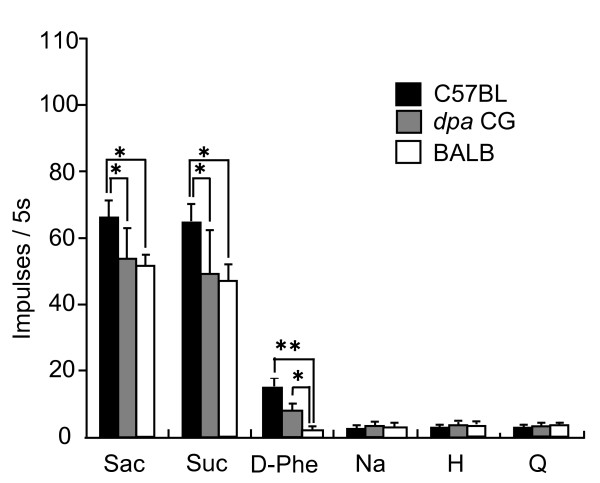
Mean numbers of impulses/5 sec of all sweet-sensitive fibers including GS and GI types in response to 6 taste stimuli in C57BL, dpa CG and BALB mice. Two-way repeated ANOVA tests indicated that the mean number of impulses to Sac, Suc and D-Phe significantly differed among the 3 strains [F (2, 77) = 3.70, P < 0.05 for Sac; F (2, 77) = 4.52, P < 0.05 for Suc; F (2, 75) = 5.52, P < 0.01 for D-Phe]. *: Post-hoc Turkey-Kramer tests: P < 0.05. Data for C57BL presented were obtained by recalculation of those from Ninomiya et al. (1999)[6]